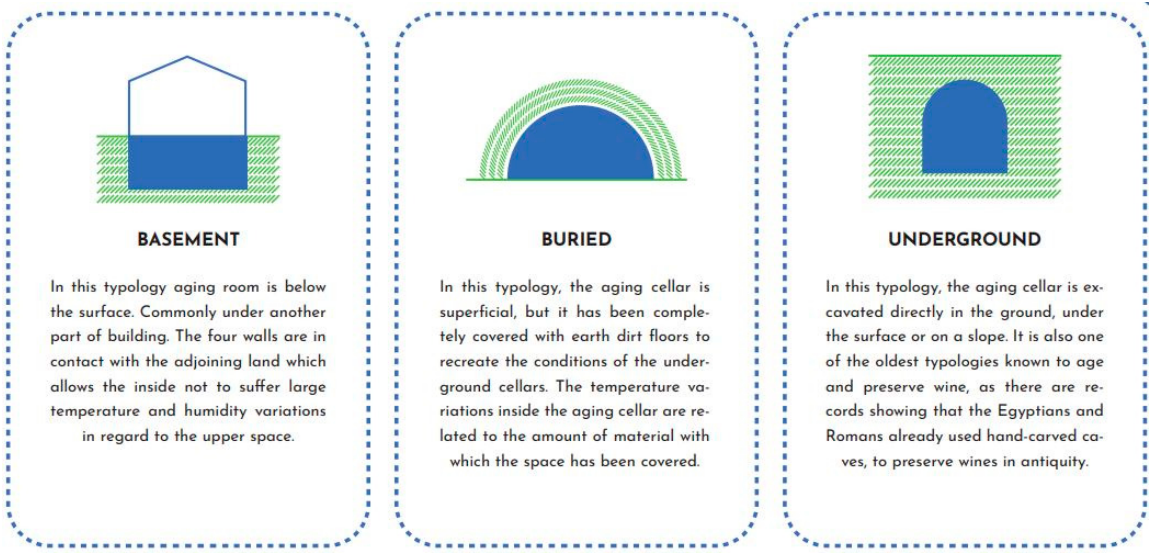
Figure 2. Type of analyzed warehouses.